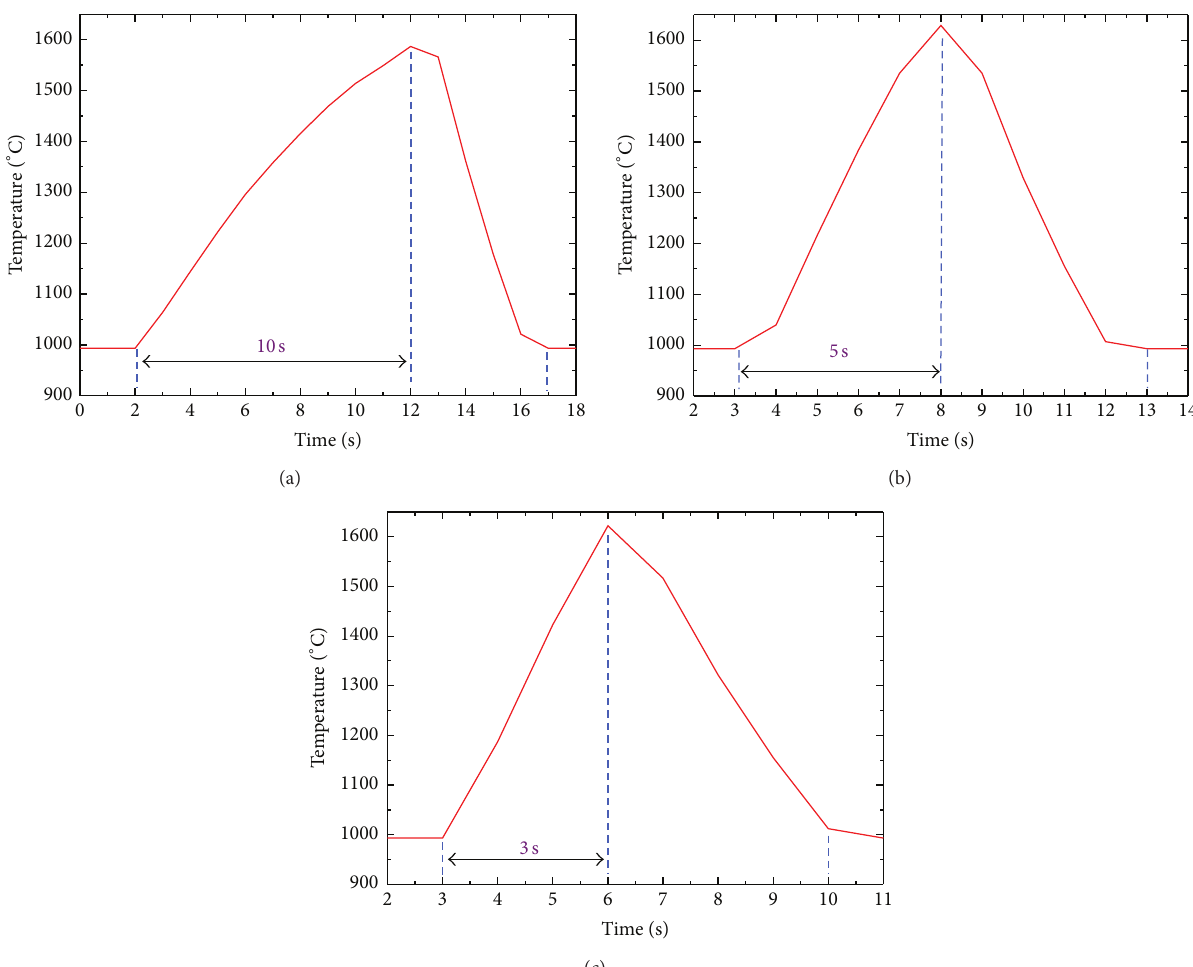
Figure 10: Temperature curves of ZSB materials under different current conditions: (a) 240 A; (b) 280 A; (c) 320 A.